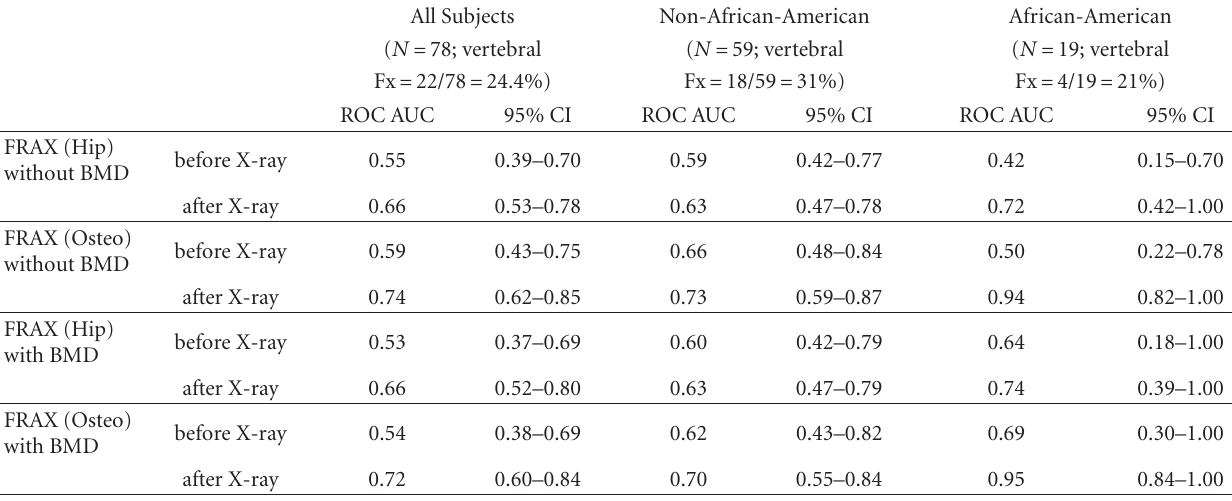
Table 4: FRAX score in the prediction of vertebral fracture in men with prostate cancer. All